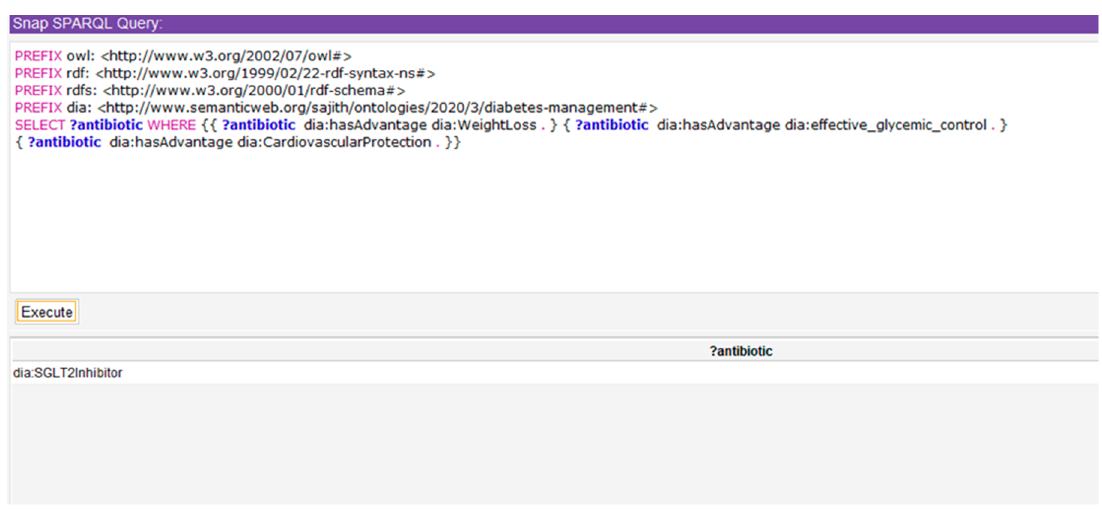
Figure 10. SPARQL query and Suggested answer for first competency question (CQ) .